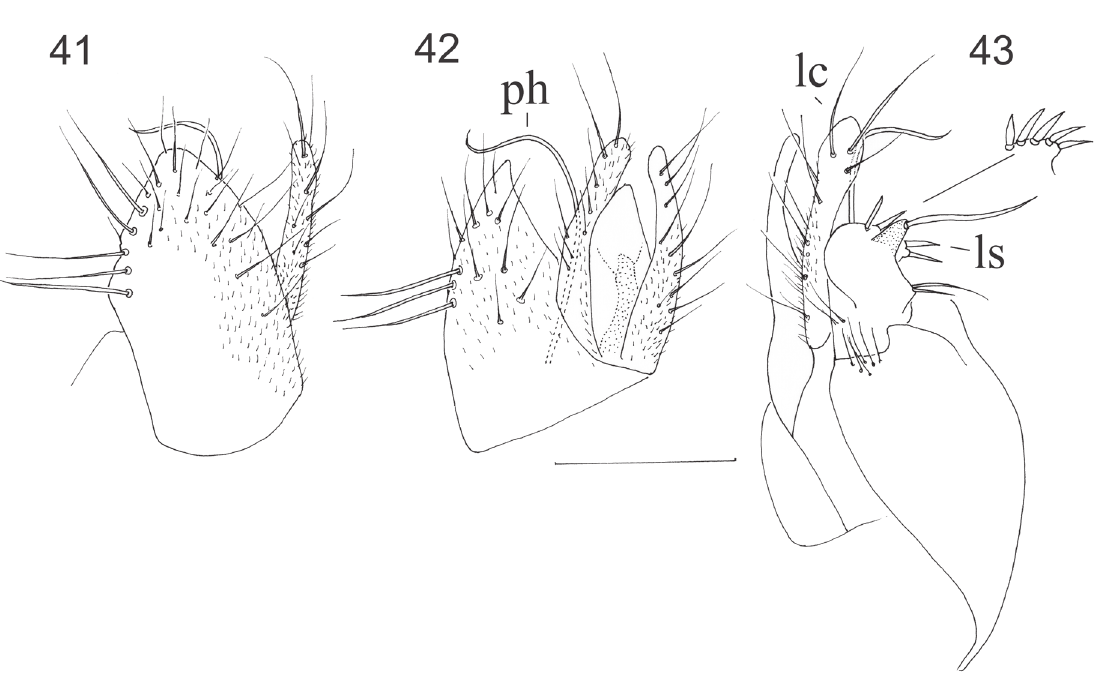
Figs 41-43. Chersodromia obscura Grootaert, Cumming & Shamshev, 2007, ♂ terminalia. 41 . right epandrial lamella, lateral view. 42 . epandrium with cerci, dorsal view. 43 . left epandrial lamella fused to hypandrium with detail of surstylus. lc = left cercus, ls = left surstylus, ph = phallus. Scale bar = 0.1 mm (after Grootaert et al .